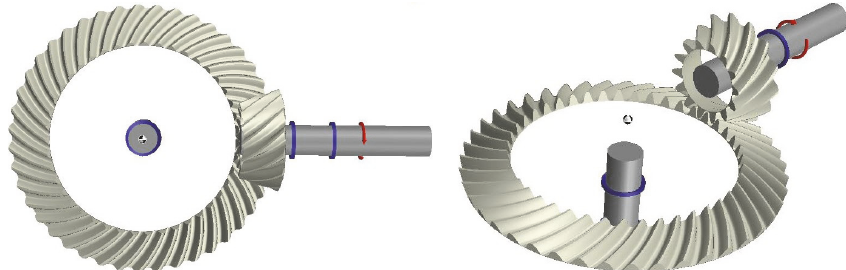
Figure 1: Mesh model of the spiral bevel gear pair.